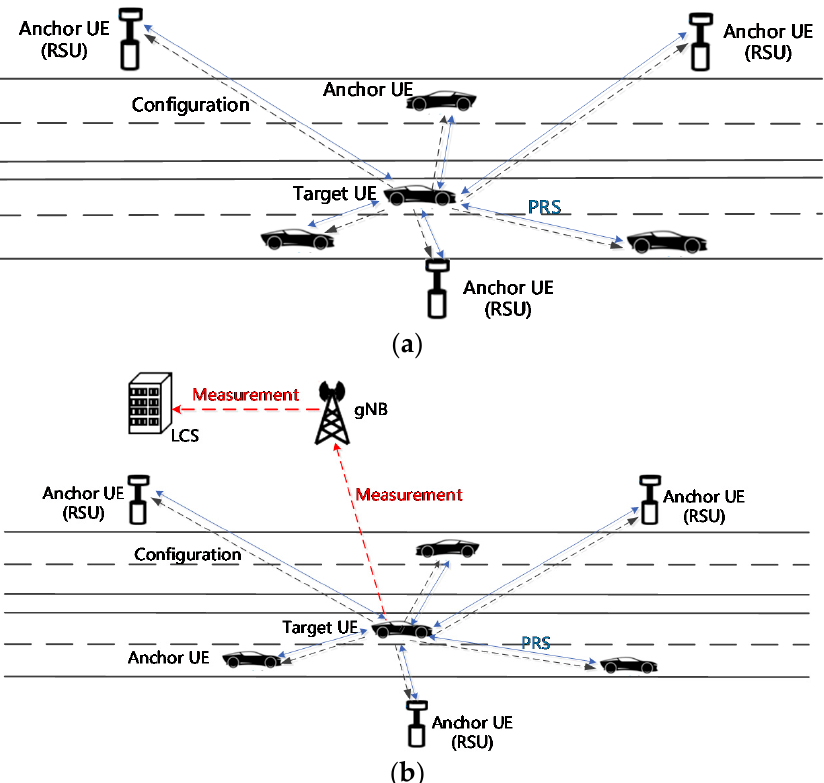
Figure 8. Two architectures of sidelink position: ( a ) UE-configured UE-based sidelink positioning architecture; ( b ) UE-configured UE-assisted sidelink positioning architecture.